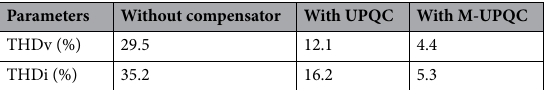
Table 5. The harmonic output voltage and current values.